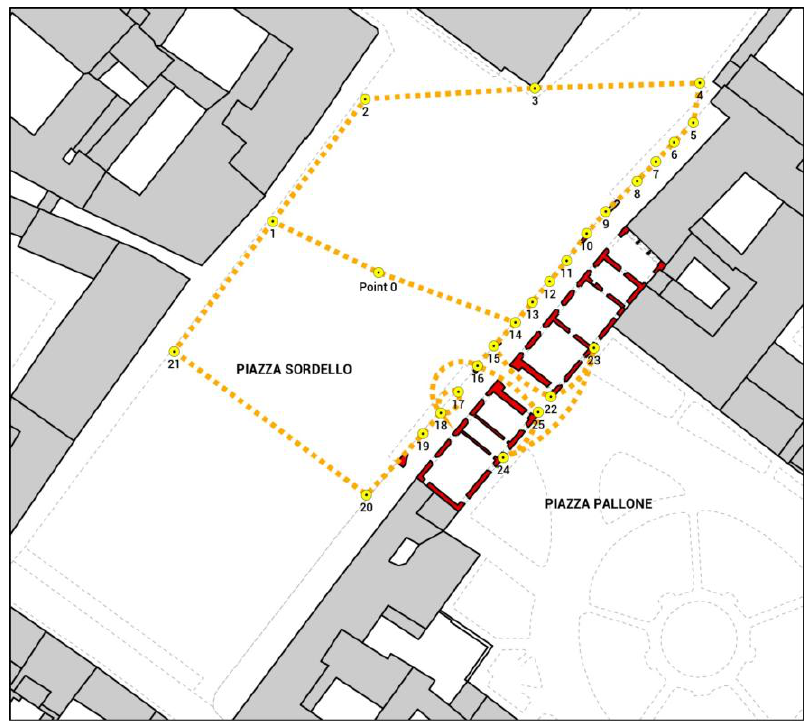
Figure 9. Plan of the leveling network with the localization of benchmarks and line